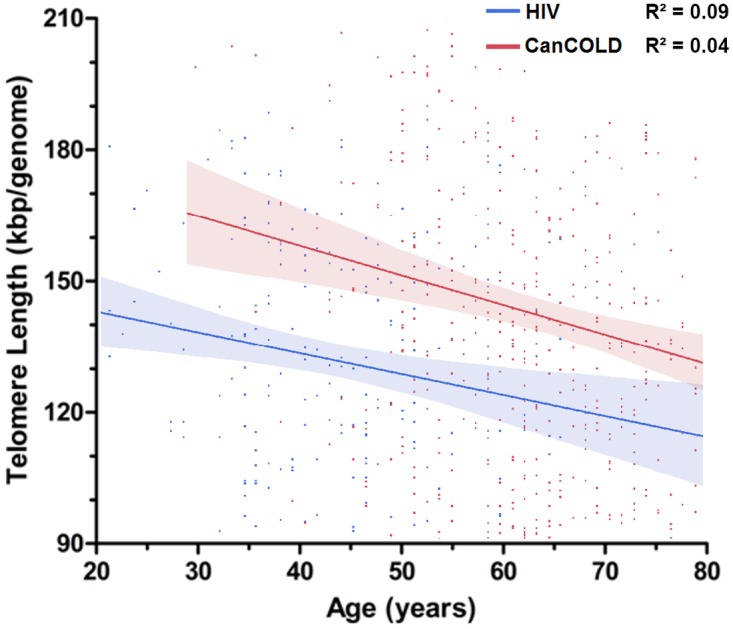
Absolute leukocyte telomere length by age for HIV-infected and non-HIV-infected individuals.When HIV-infected individuals (blue) are compared to non-HIV-infected individuals (red) from the CanCOLD cohort, significant differences in telomere length are seen. The respective slopes of aTL vs. age do not differ significantly between CanCOLD and HIV populations (p = 0.469). Solid lines represent the regression line; shaded areas represent the 95% confidence interval; the analysis has been adjusted for sex, BMI, smoking history and FEV1%Pred.